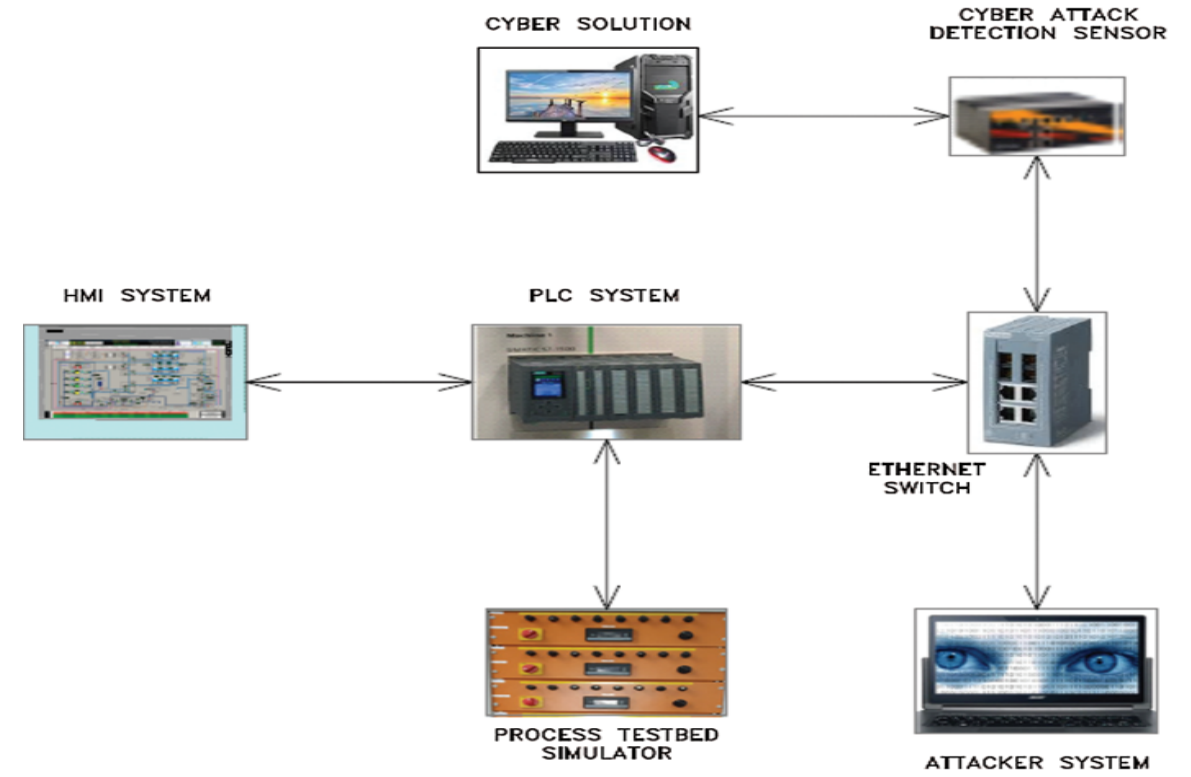
Figure 3. ICSs portable testbed prototype [36].